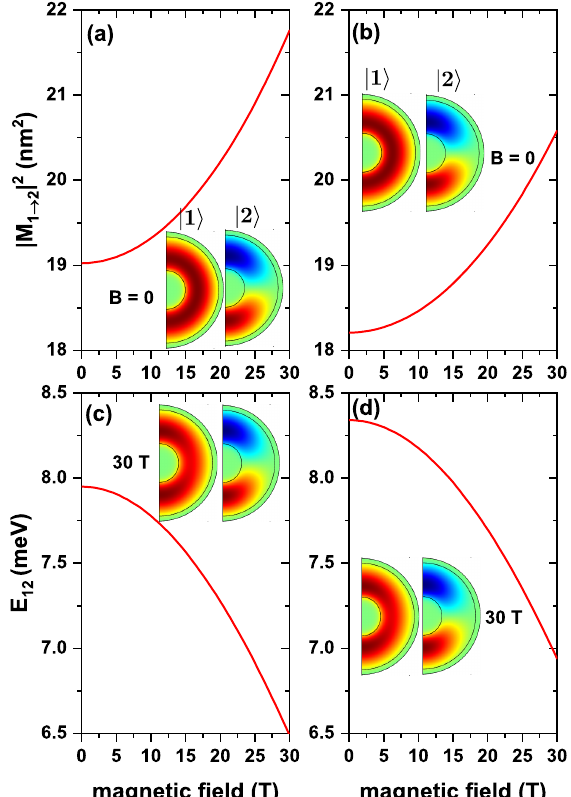
Figure 6. The variation of | M 12 | 2 ( a , b ), and the transition energy ( c , d ), as a function of the magnetic field, for transitions from the ground state ( | 1 (cid:105) ) to the first excited state ( | 2 (cid:105) ) with m = 0, for an electron confined in a ZnS/CdS/ZnS spherical QD. ( a , c ) are without, and ( b , d ) are with the effects of a donor impurity located at the QD center. Calculations are with R 1 = 4 nm, R 2 = 11 nm, and R 3 = 12 nm, without electric field